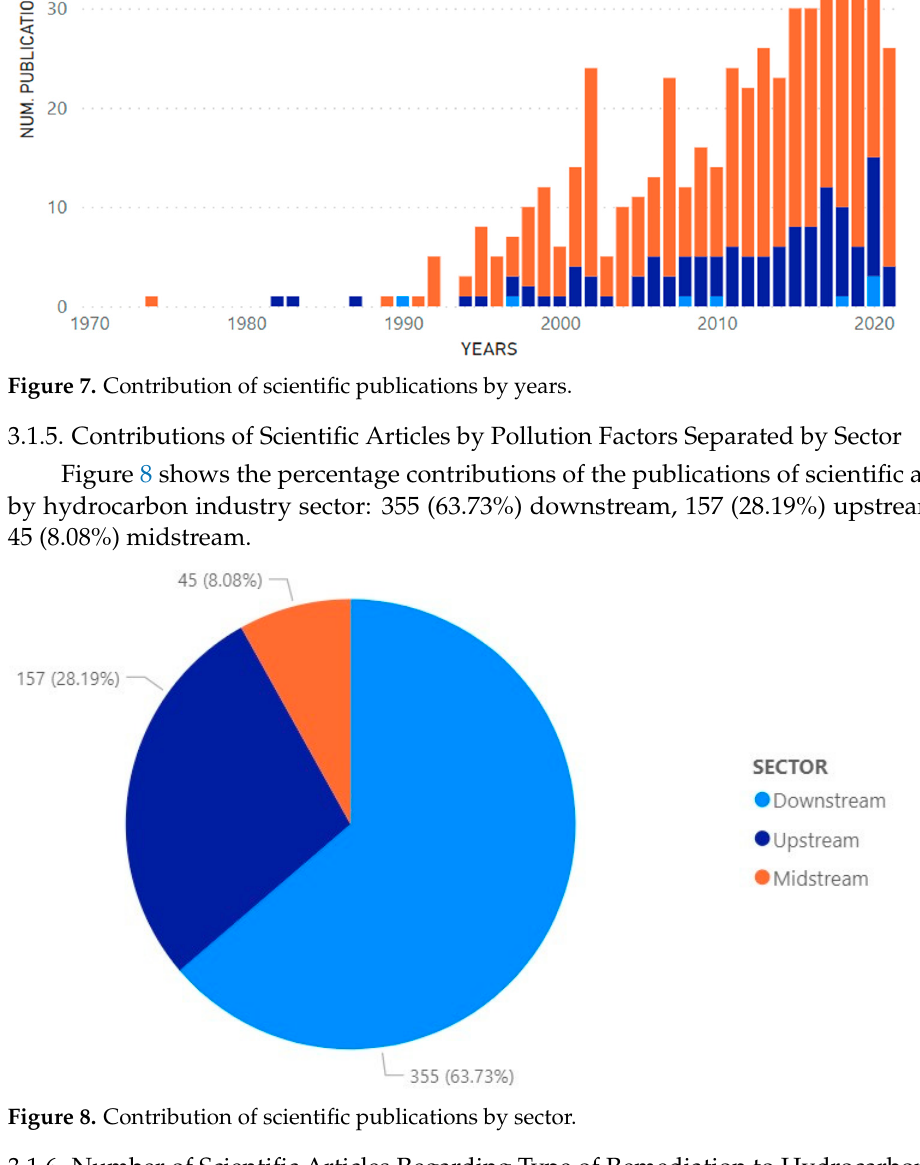
Figure 9. Contribution of scientific remedial publications by years.